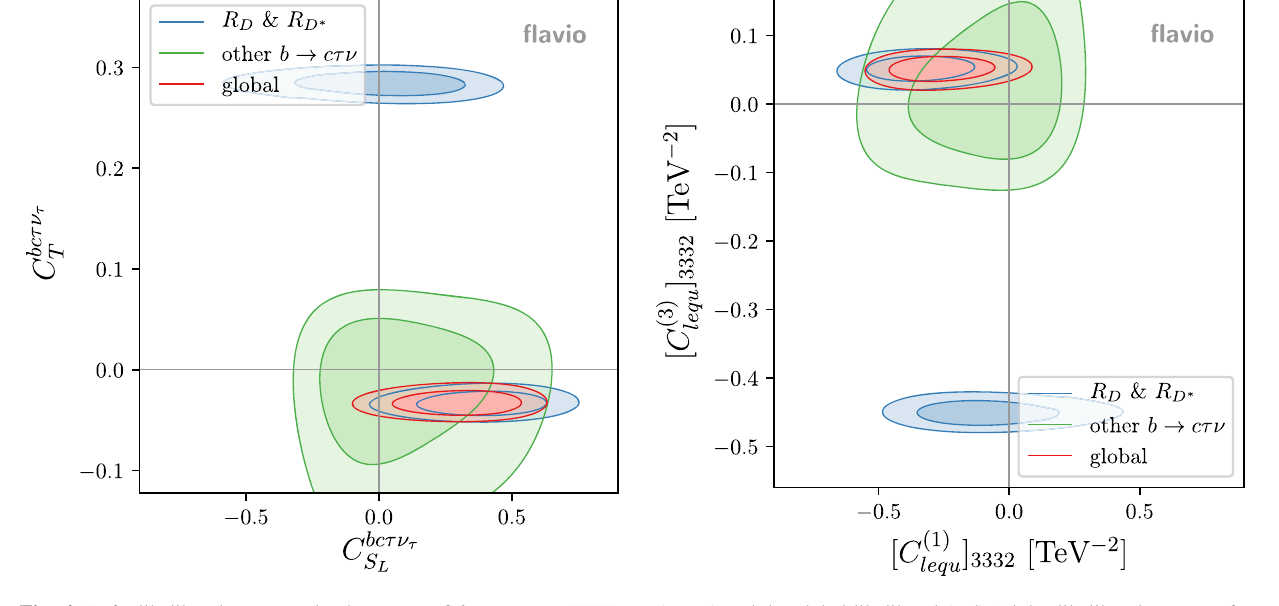
(green) and the global likelihood (red). Right: likelihood contours for the SMEFT Wilson coefficients matching onto the WET scalar and tensor